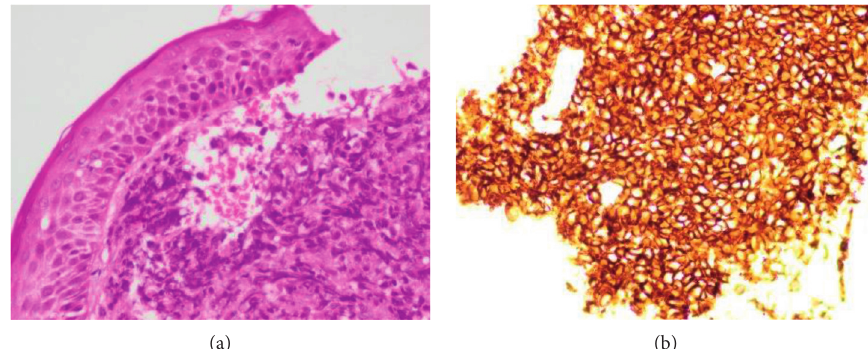
Figure 4: IHC analysis of skin biopsy. (a) The subcutaneous tissue infiltrated by diffuse sheet of atypical large lymphoid cells with vesicular nuclei, prominent nucleoli, and moderate cytoplasm (hematoxylin and eosin (H&E staining, x20). (b) Strongly membranous positive CD 20 in lesional lymphoid cells (IHC-CD20,